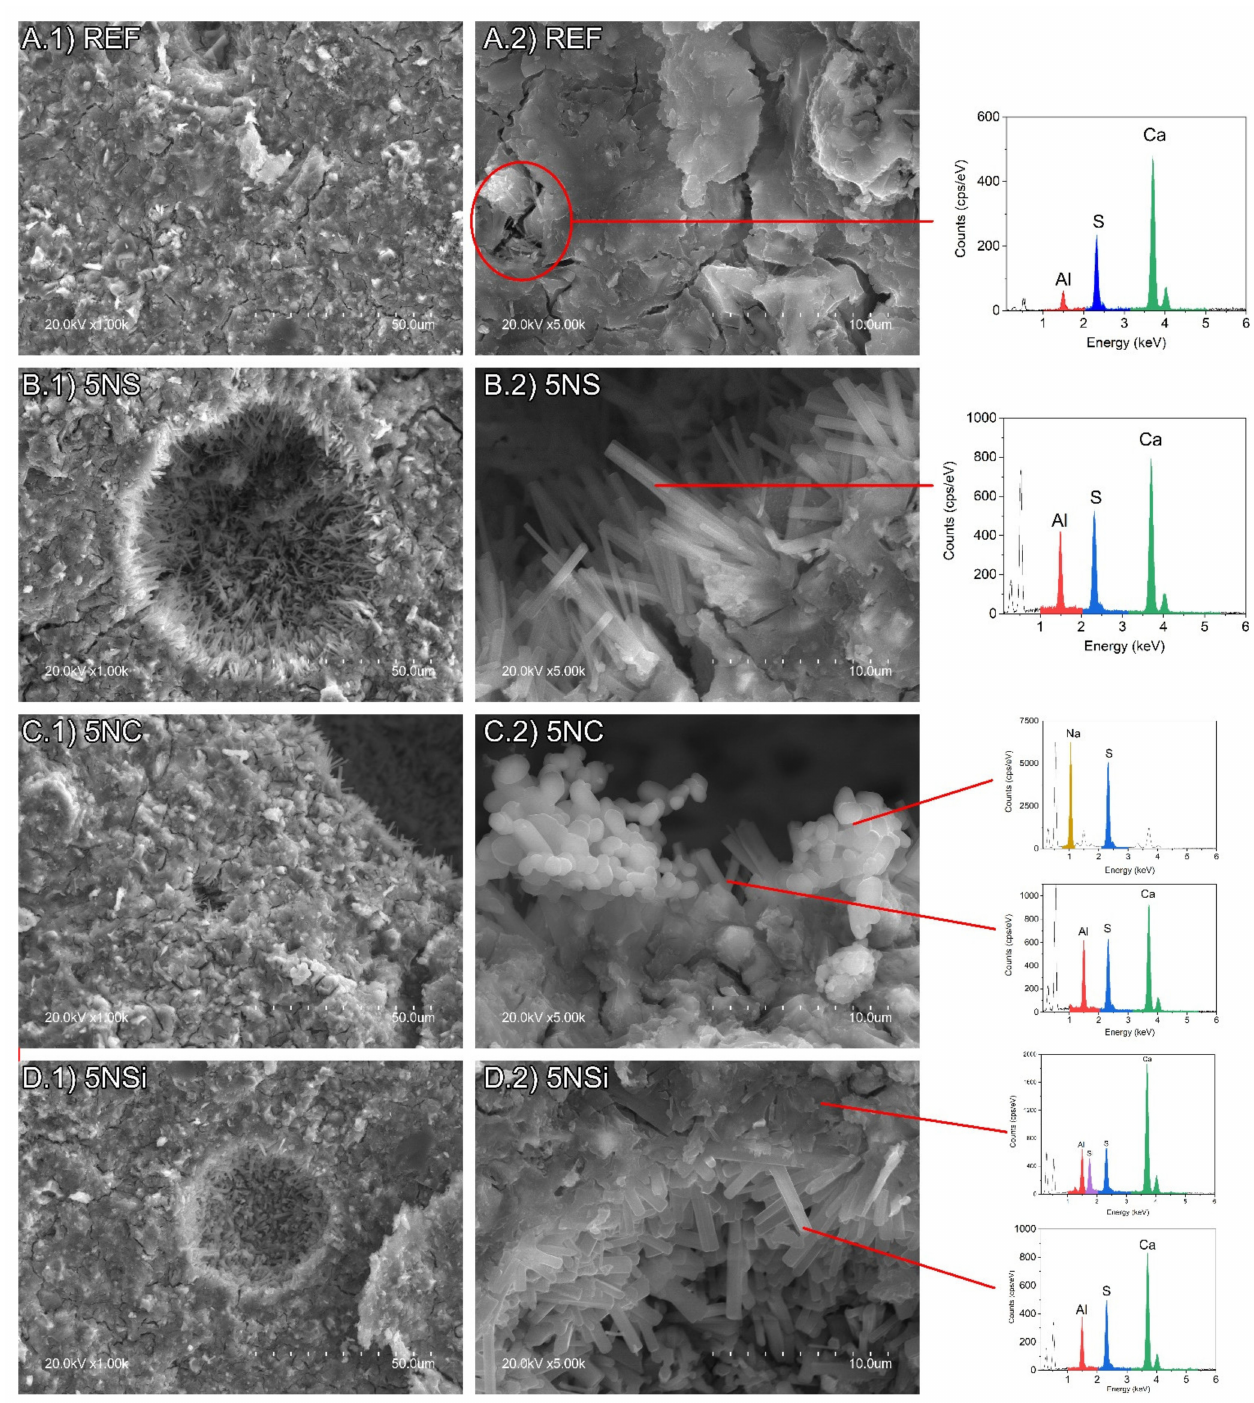
Figure 6. Scanning electron microscope (SEM) micrographs (at 1000 × and 5000 × ) of 28-d: ( A ) REF; ( B ) 5NS; ( C ) 5NC; and ( D )